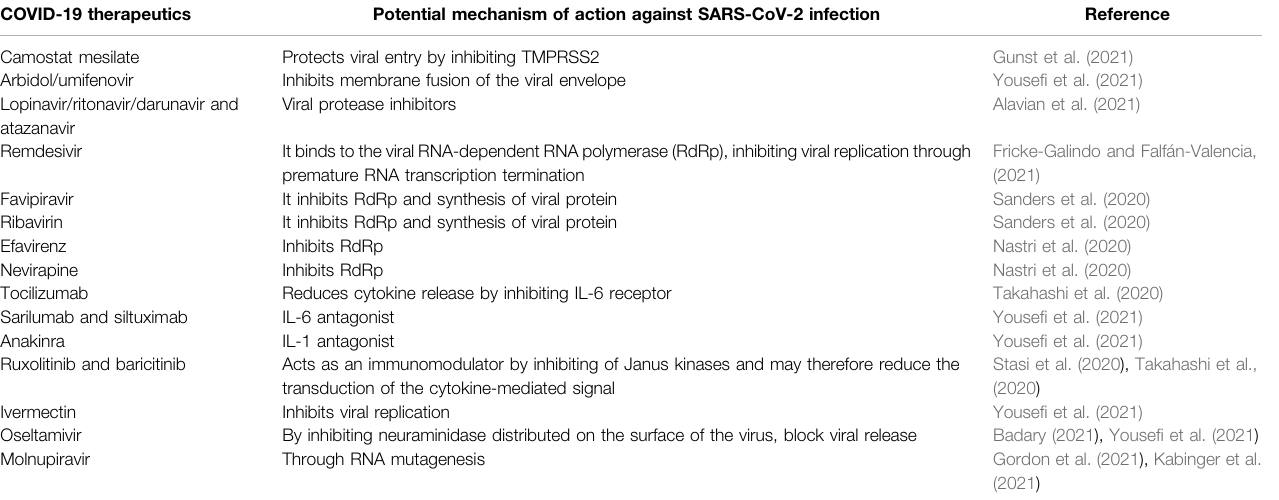
TABLE 1 | Possible mechanism of actions of COVID-19